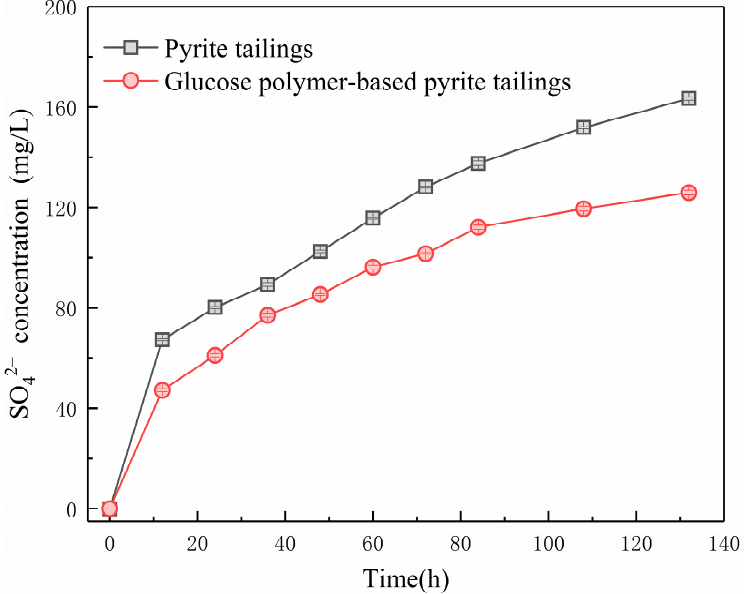
Figure 8. Variation of SO 42 − concentration in denitrification system before and after pyrite tailings coating.